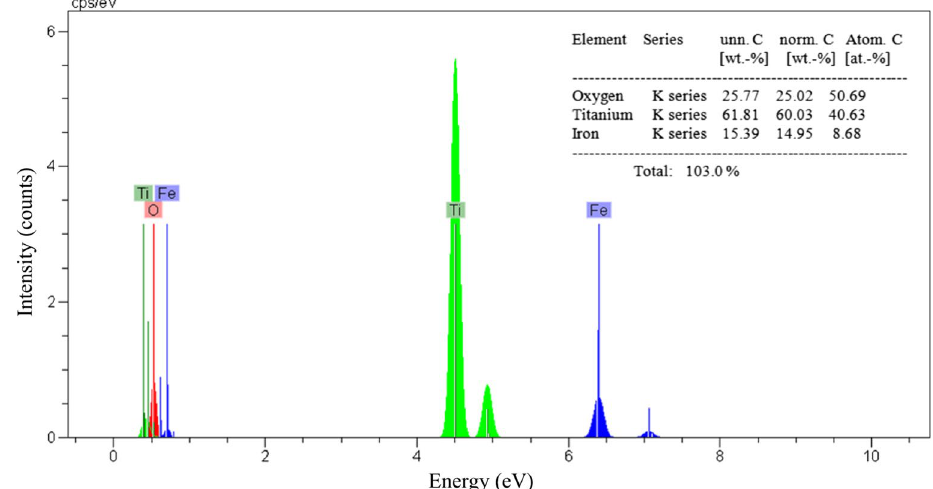
Fig. 7 EDX spectrum analysis